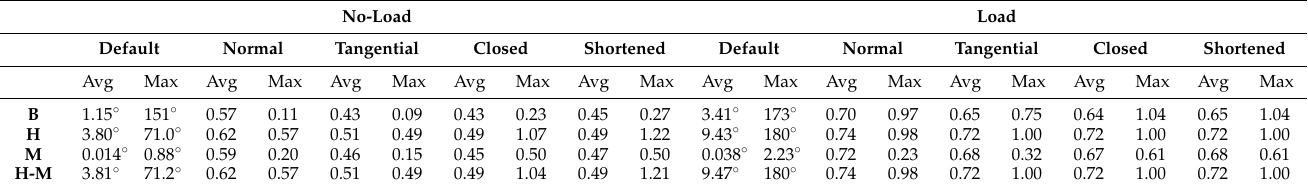
Table 6. Angular dependency of magnetic flux density B , magnetic field strength H and magnetization M for the rotating machine due to pole shoe alterations under no-load and load. For the design alterations, the inclination angels are given as a fraction of the respective inclination angle for the default case. The pole shoe alterations are illustrated in Figure 7.